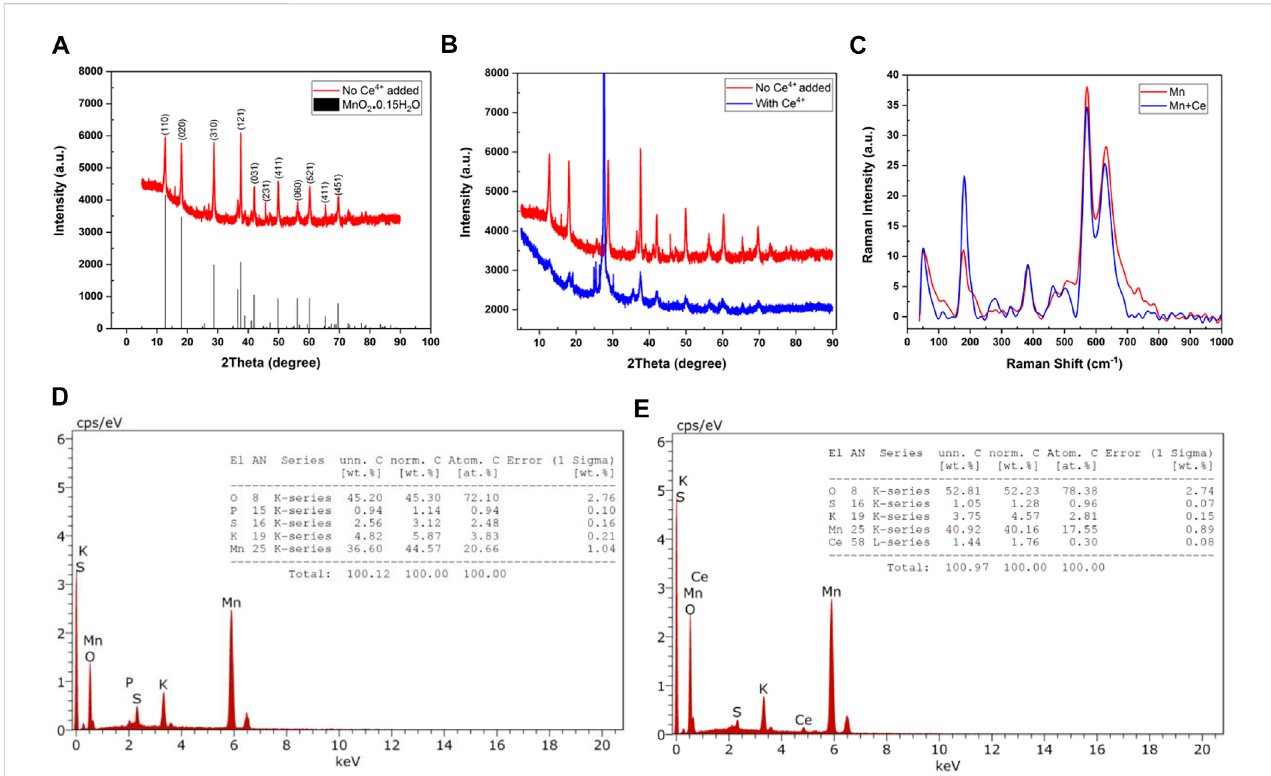
FIGURE 1 XRD spectra of the solids produced by hydrothermal reaction (A) in absence (with α -MnO 2 · 0.15 H 2 O as reference) and (B) in presence of Ce 4+ ions. (C) Raman spectra of MnO 2 and Ce-MnO 2 prepared by hydrothermal method. EDX spectra and elemental analysis results of (D) MnO2 and (E) Ce-MnO 2